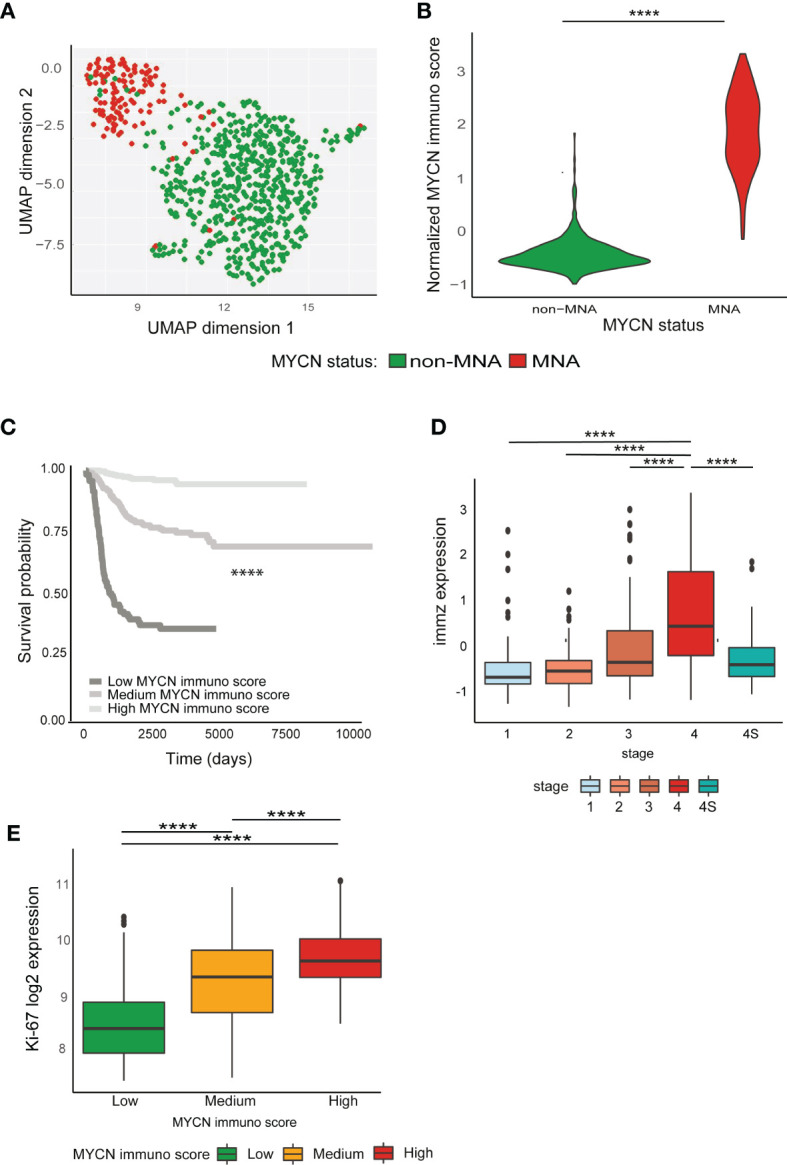

MYCN effect on immune system has a prognostic impact. (A–E) Analyses conducted on E-MTAB-1781 dataset. (A) Uniform Manifold Approximation and Projection (UMAP) projection of MYCN amplification (MNA) and non-MNA patient gene expression profiles (PGEP). (B) Violin plots represent normalized MYCN immune score in MNA and non-MNA PGEP. (C) Kaplan–Meier plots for the probability of overall survival over time for patients associated with MYCN immune score (high enriched, n = 114; medium enriched, n = 311; low enriched, n = 277). Associated P value is shown in the middle of the plot (log-rank test). (D) Normalized MYCN immune score in different International Neuroblastoma Staging System Committee (INSS) classification stages. (E) Ki-67 log2 expression in patients associated with MYCN immune. Wilcoxon matched pair test; ****P < 0.0001.